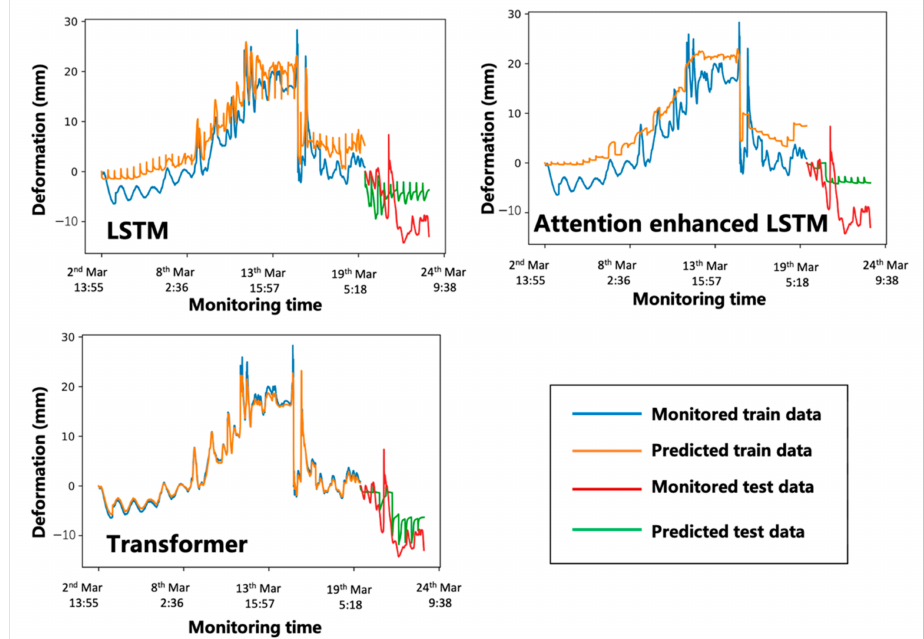
Figure 12. The training and testing results of the LSTM model, the attention-enhanced LSTM model, and the transformer